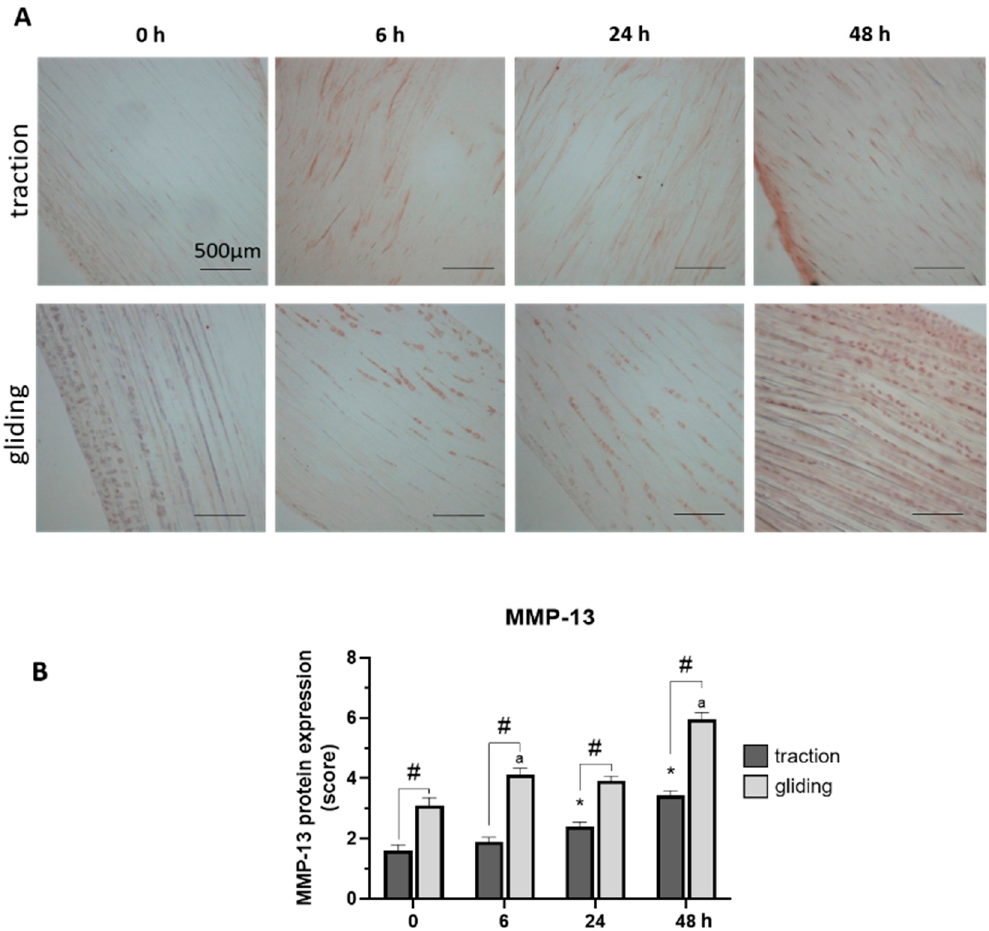
Figure 5. E ff ects of uniaxial treatment on matrix metalloproteinase-13 (MMP-13) expression in traction and gliding tendons. ( A ) Representative images of immunohistochemically stained sections against MMP-13 in traction (upper panel) and gliding (lower panel) region after 48 h of uniaxial force application. ( B ) Scoring of MMP-13 in the traction region revealed a slight increase in the expression of MMP-13; its highest expression came about at 48 h of treatment. A similar increase was observed in the gliding tendon. Note that MMP-13 exhibited a slower protein expression response to the application of uniaxial force than MMP-1 did. Further, MMP-13 expression was higher in the gliding tendon during the whole experiment. Asterisks indicating statistical di ff erences in comparison to the 0 h control time point within the traction group, letters indicate statistical di ff erence in comparison to the control time point within the gliding group, and hashtags indicate traction vs. gliding within the di ff erent time points.